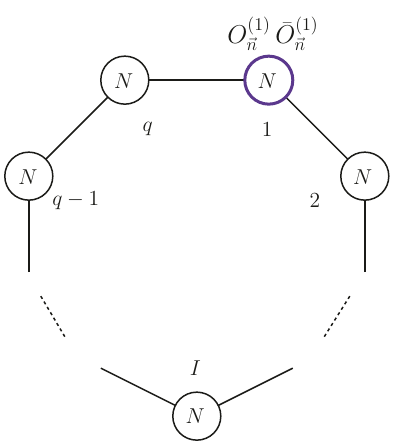
Figure 4. The circular quiver with q nodes associated to the theory A q − 1 . The operators O (1) and ¯ O (1) belong to the same node, highlighted in ~n